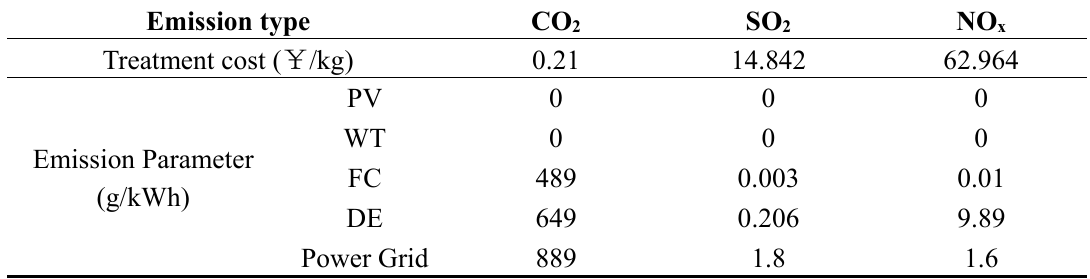
Table 4. Parameters of carbon dioxide and pollutant